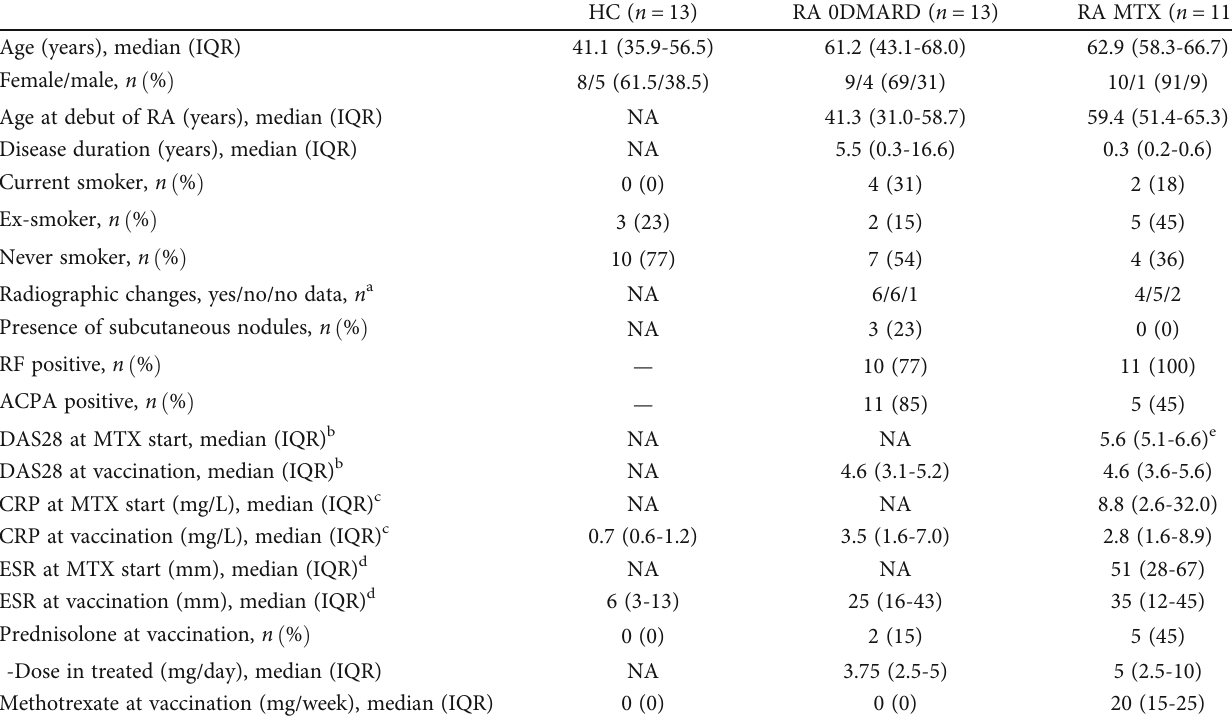
Table 1: Demographic pro fi le and characteristics of study